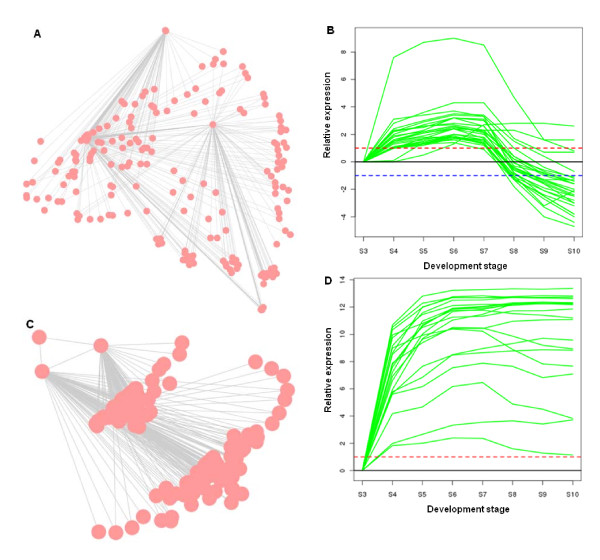
Subnetwork and temporal expression profiles for genes involved in seed storage reserve accumulation in developing Arabidopsis seeds. A is the subnetwork for genes including those in fatty acid (FA) biosynthesis, and B depicts the expression profiles of FA biosynthetic genes identified in the analysis. C is another subnetork including genes encoding oleosins and seed storage proteins (SSP), and D depicts the expression profiles of genes encoding oleosin and SSP. In B and D, the expression values, AGI identifiers of the genes depicted are listed in Additional File 3, and the log2 expression values were standardised by subtracting the value at the first S3 stage for each gene. Dashed red, blue lines indicate 2-fold up- or down-regulation, respectively.